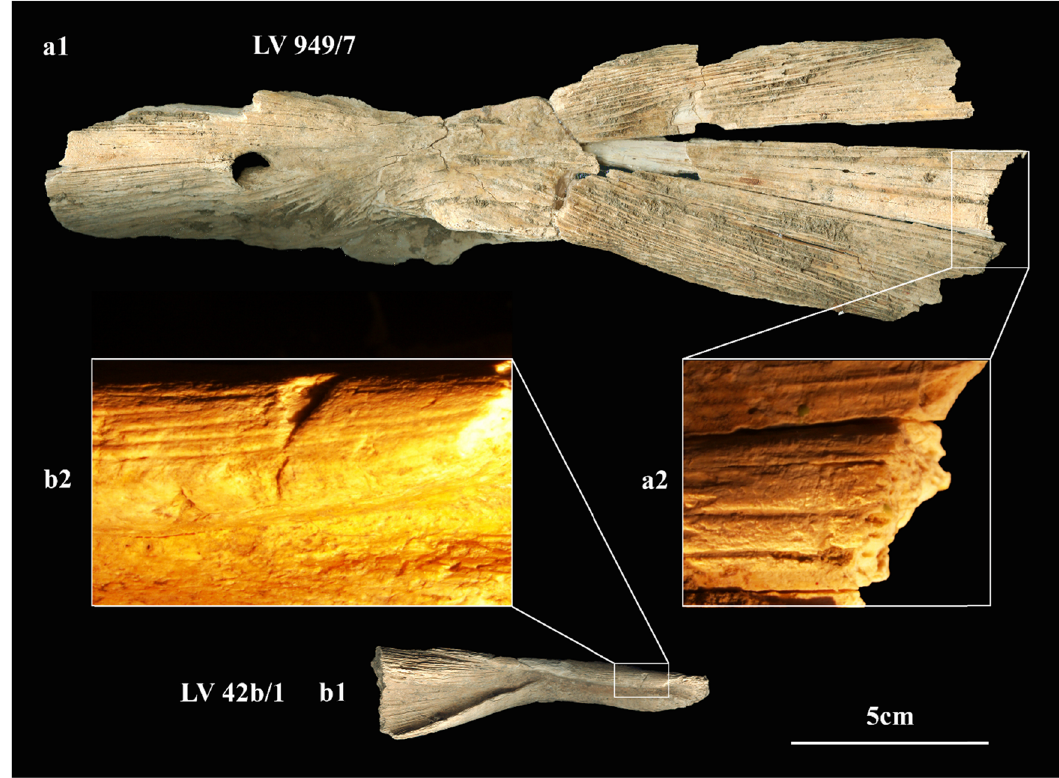
Figure 14: LV 949/7: ( a1 ) beluga sturgeon parasphenoid ( sq. C/III, spit IX, probably Early Neolithic ) , with several transverse cut marks on the ventral side, 7.5 × magni fi cation ( a2 ) ; LV 42b/1: ( b1 ) beluga sturgeon left dentary ( burial 42b, Early Neolithic ) , with a chop mark on the medial side, 10x magni fi cation ( b2 ) ( Figure 9.17 in Ž ivaljevi ć , 2017 )